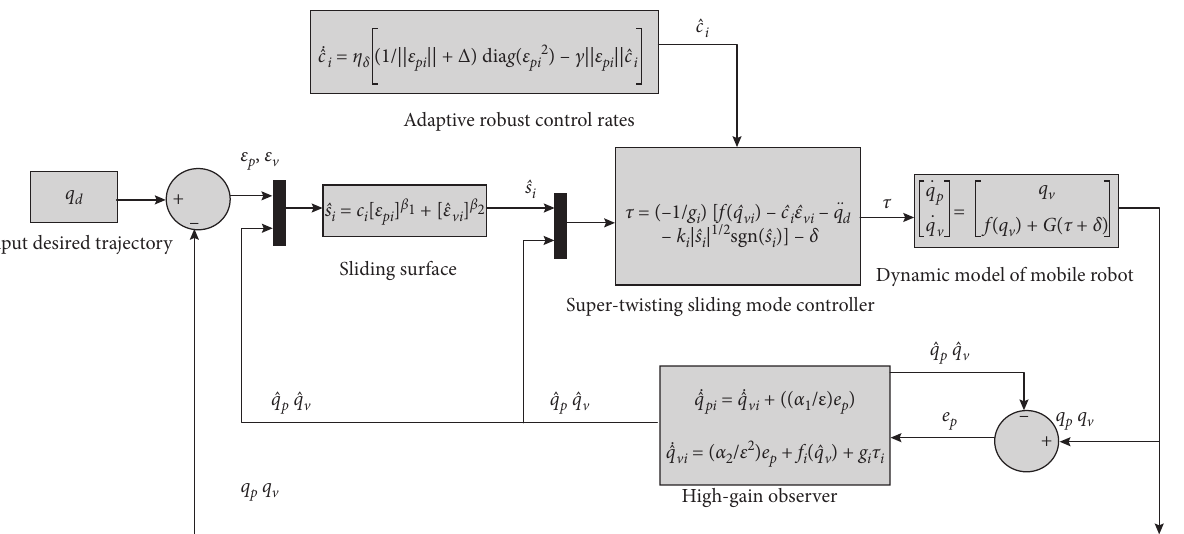
Figure 2: Block diagram of the super-twisting control based on a high-gain